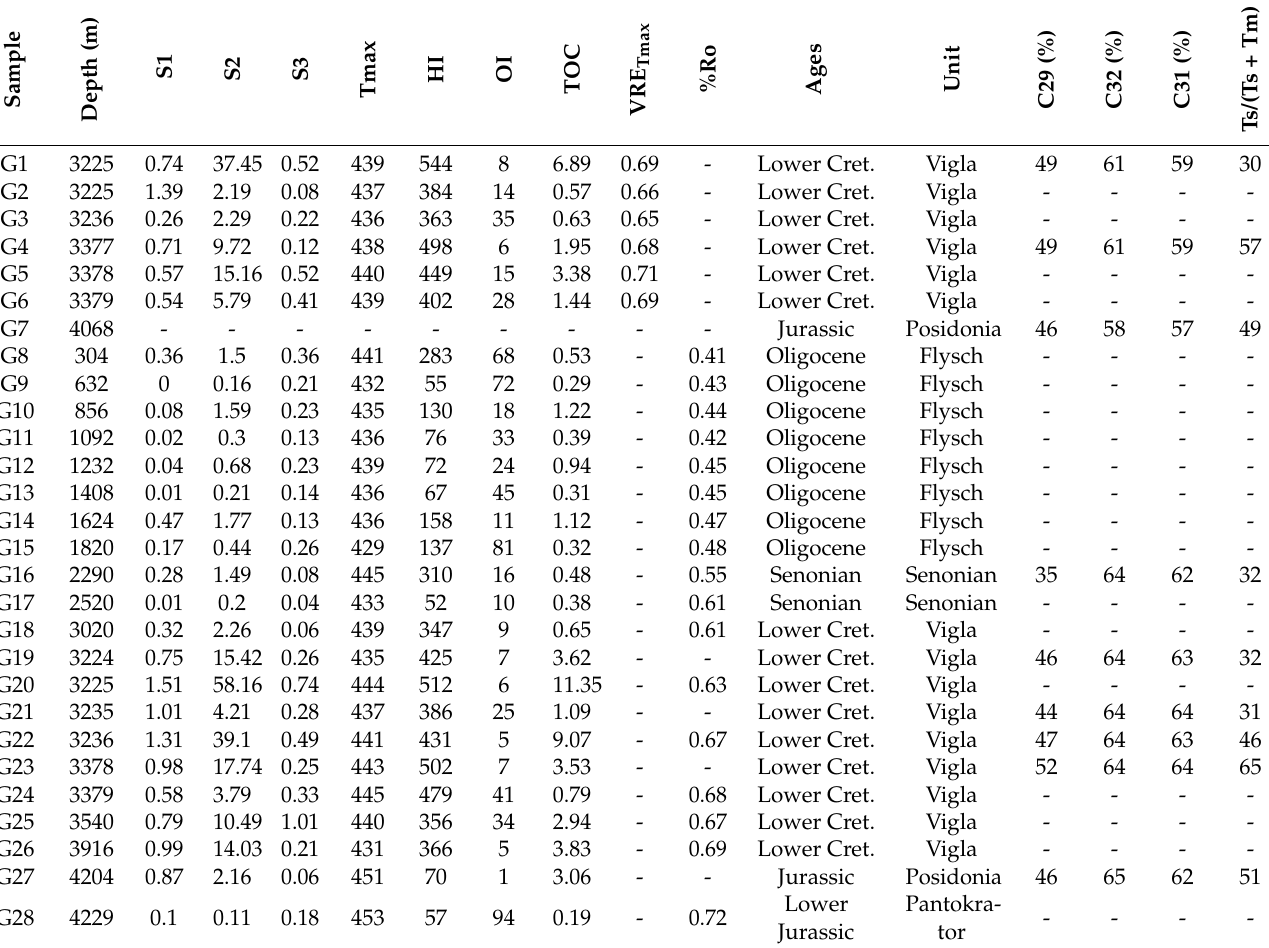
Table 1. Table including own samples analyzed on this study (G1–G7) and samples from [9] (G8–G28). RE6 pyrolysis parameters for G1–G7 and RE2 for G8–G28. Equivalent VR values VRE Tmax (%) for G1–G7, based on [75]. Vitrinite reflectance values (%Ro) for G8–G28 accord- ing to [9]. RE parameters are as follows: S1, S2 (mgHC/grock), S3 (mgCO 2 /grock), Tmax ( ◦ C), HI (mgHC/gTOC), OI (mgCO 2 /gTOC). Biomarker isomerization ratios are as follows: C29 (%): C29 ααα 20S/(20S + 20R) sterane, C31 and C32 (%): C31 and C32 22S/(22S + 22R), and Ts/(Ts + Tm): 18 α -22,29,30-trisnoreohopane/(18 α -22,29,30-trisnoreohopane + 17 α -22,29,30-trisnorhopane). Cret. refers to Cretaceous and depth to measured